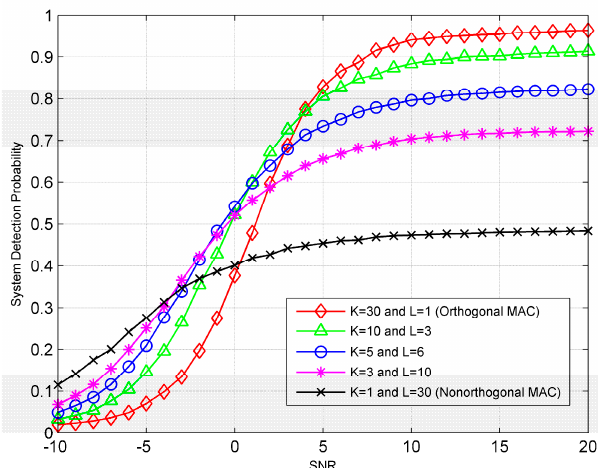
Figure 4. The probability of detection as a function of channel SNR for the ED fusion rule.